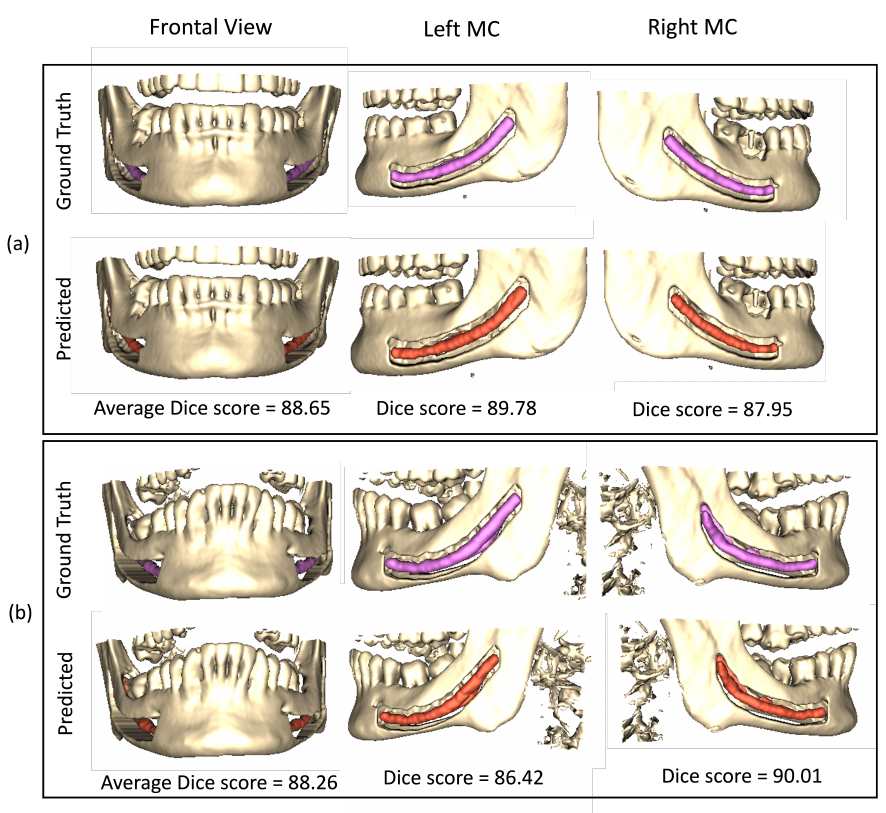
Figure 7. Visual results of our proposed model on public dataset on 3D rendered medium view CBCT scans. Sub-figures ( a , b ) show results from two different samples. The first and second row of each sub-figure represent the ground truth and predicted results,